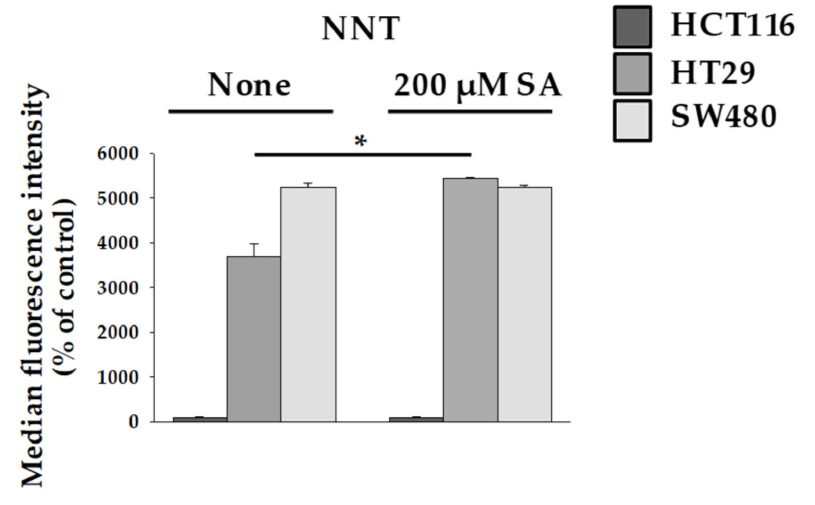
Figure 4. Measurement of nicotinamide nucleotide transhydrogenase (NNT) activity. HCT116, HT29, and SW480 were treated with 200 µ M SA for 48 h. Data are representative values of three independent experiments and expressed as mean ± SD ( n = 3), * p <